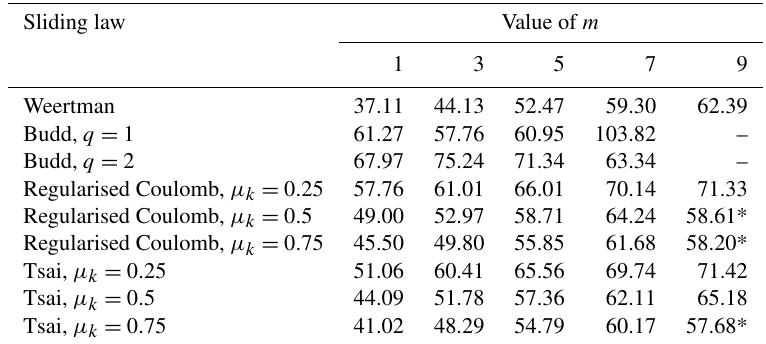
Weertman Budd, q = 2 Regularised Coulomb, µ k = 0 .